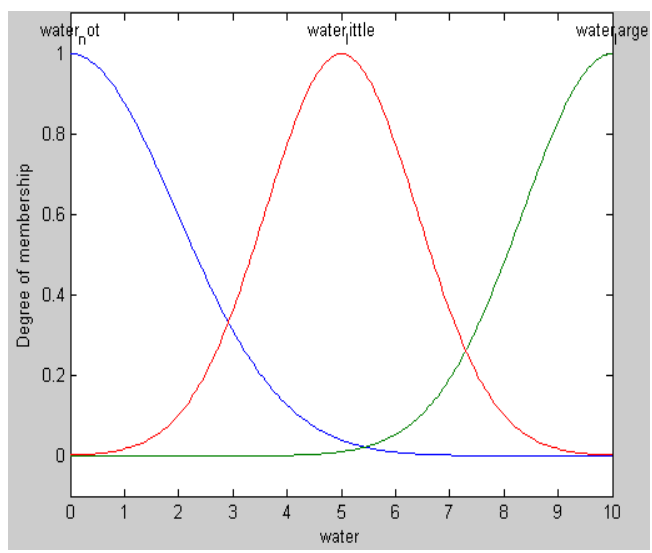
Figure 4. The degree of moisture on the road.